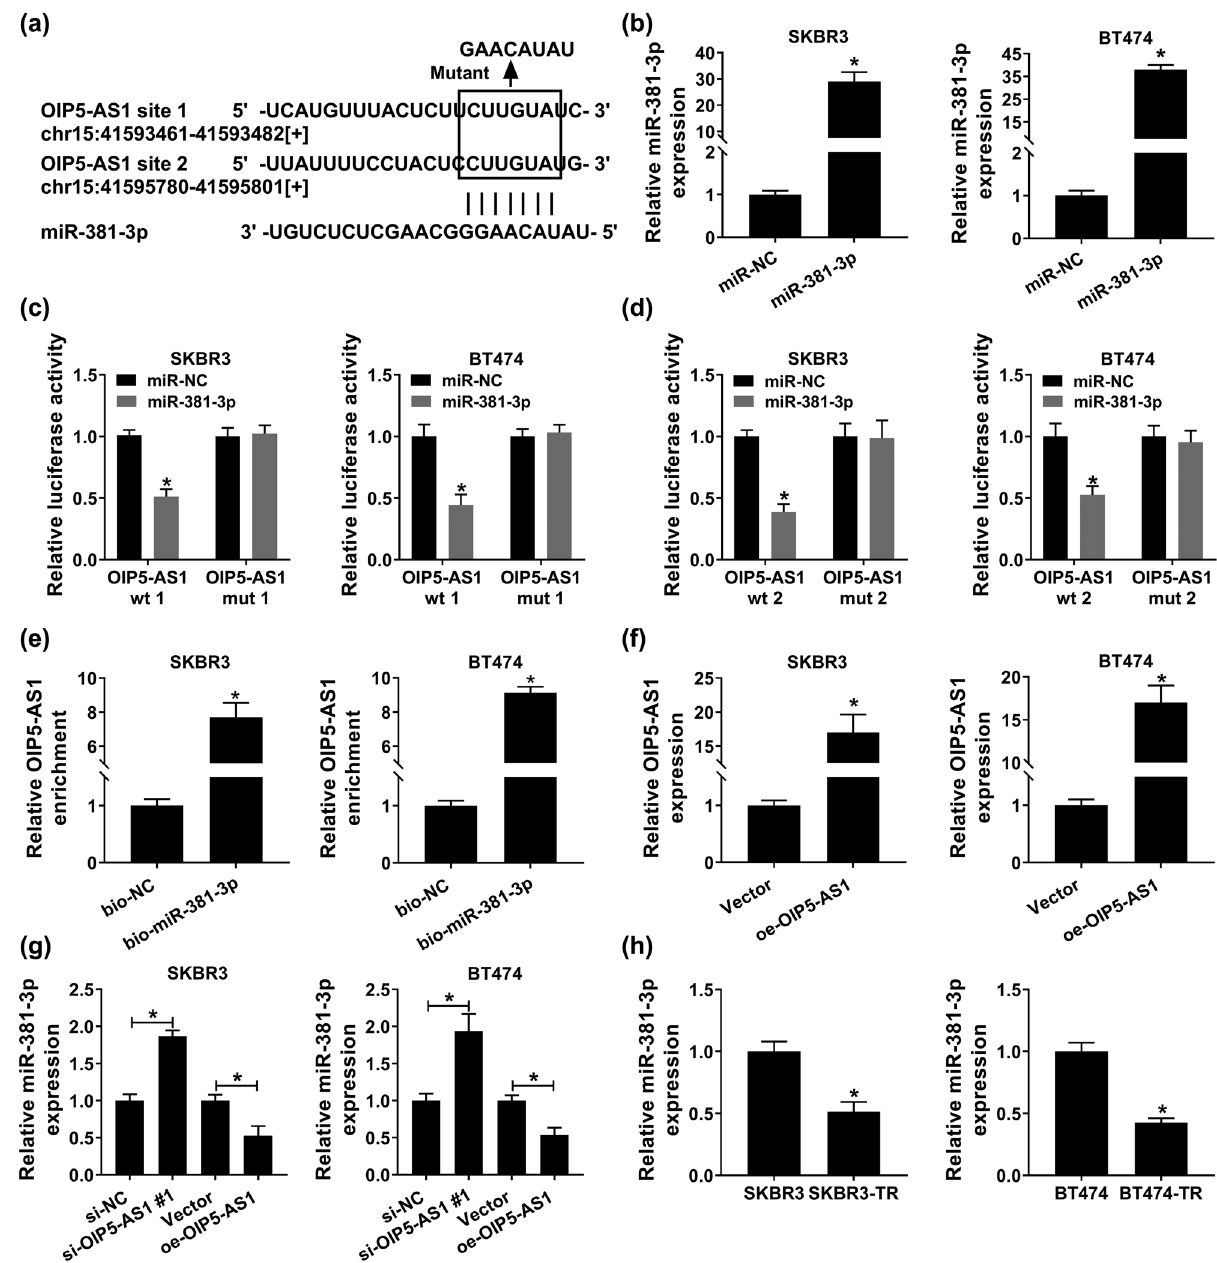
Figure 5: OIP5 - AS1 is a sponge of miR - 381 - 3p. ( a ) The potential binding sites of OIP5 - AS1 and miR - 381 - 3p. ( b ) qPCR analysis of miR - 381 - 3p in SKBR3 and BT474 cells transfected with miR - NC or miR - 381 - 3p. ( c and d ) Dual - luciferase reporter assay in SKBR3 and BT474 cells co - transfected with the reporter plasmid and the indicated miRNAs. ( e ) qPCR analysis of the enrichment level of OIP5 - AS1 pulled down by bio - miR - 381 - 3p or bio - NC in SKBR3 and BT474 cells. ( f ) qPCR analysis of OIP5 - AS1 in SKBR3 and BT474 cells transfected with oe - OIP5 - AS1 or Vector. ( g ) qPCR analysis of miR - 381 - 3p expression in SKBR3 and BT474 cells transfected with oe - OIP5 - AS1, Vector, si - NC, or si - OIP5 - AS1#1. ( h ) Detection of levels of miR - 381 - 3p in parental and resistant breast cancer cells with qPCR. * P <